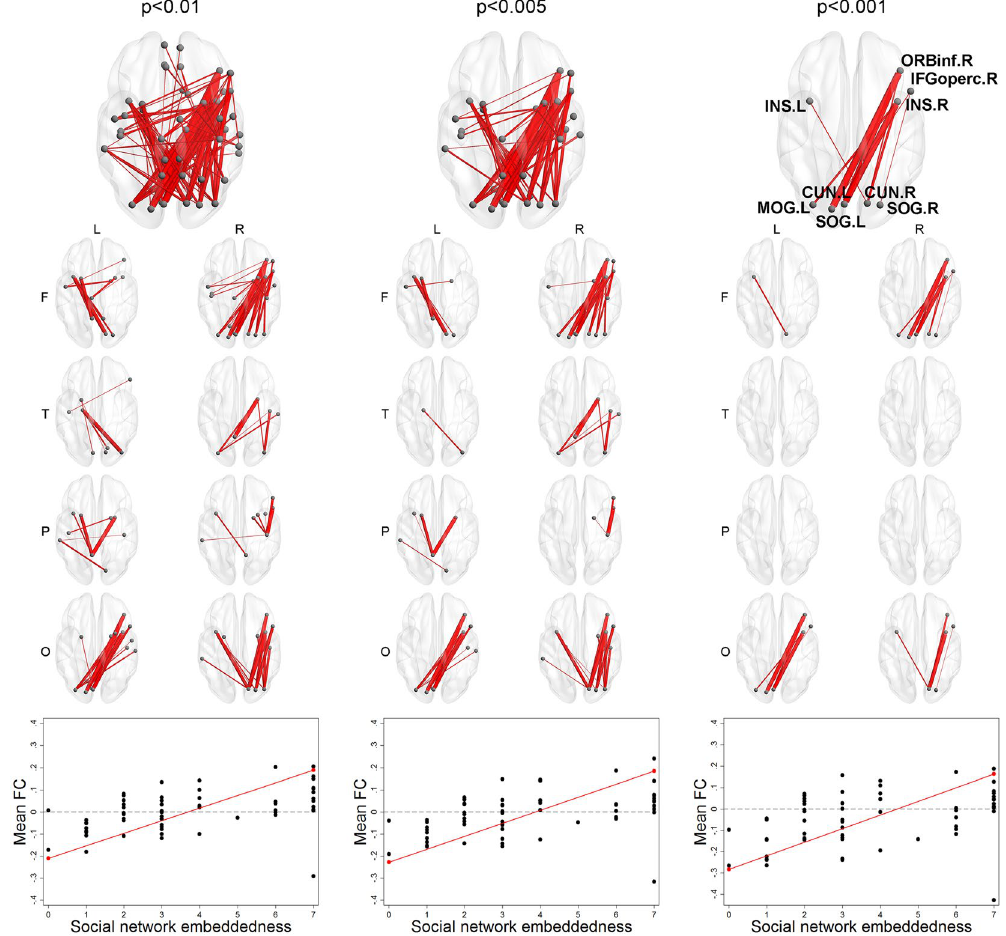
Figure 5. Component-level associations between functional connectivity and social network embeddedness (continuous). A brain figure for the whole component and eight separate figures for the regional connectivity from left/right frontal/temporal/parietal/occipital lobes are presented for each threshold. The largest component positively associated with social network embeddedness at the thresholds of p < 0.01, p < 0.005, or p < 0.001 had significantly larger extent and intensity than simulated networks. Mean functional connectivity among the ROIs in each component was higher for those with higher social network